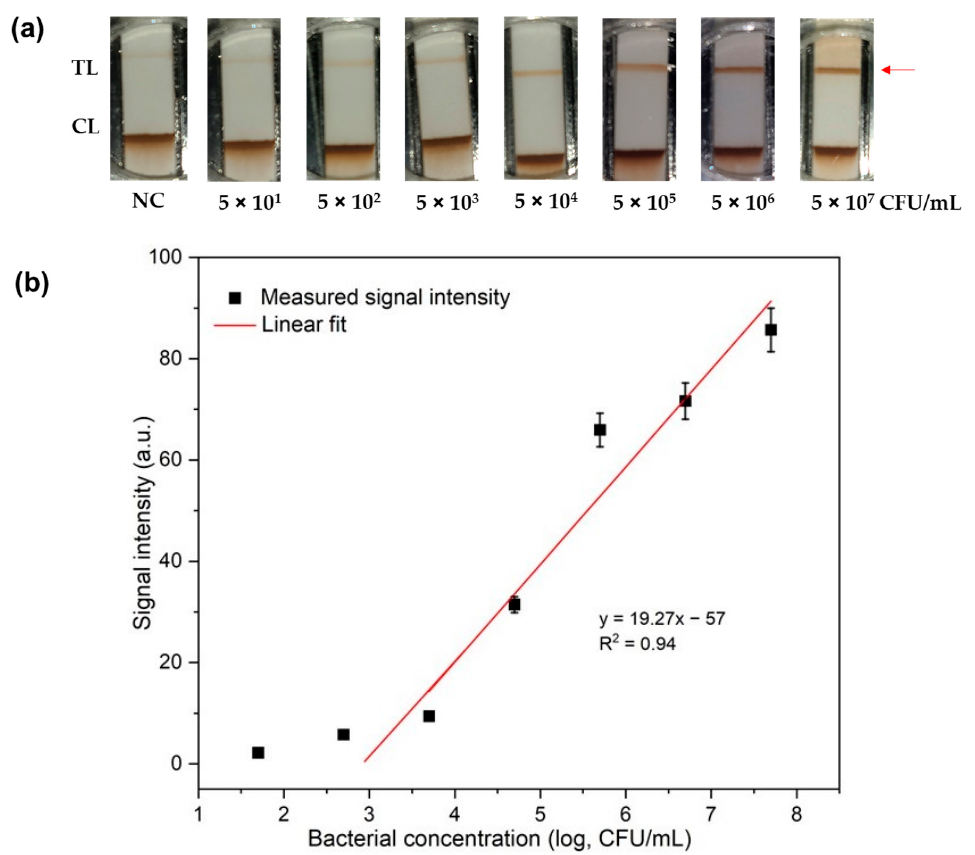
Figure 4. ( a ) Photos showing the signal generation on the NC strip of bacteria concentration 5 × 10 0 to 5 × 10 7 CFU/mL. TL and CL are the test line and control line, respectively. The red arrow indicates the location of the test line. ( b ) Graph showing the calibration curve and the linear fit.